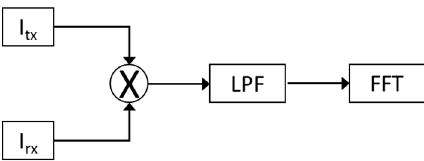
Figure 8. Processing algorithm performed on LabView software (v14.0, National Instruments, Austin, TX, USA).